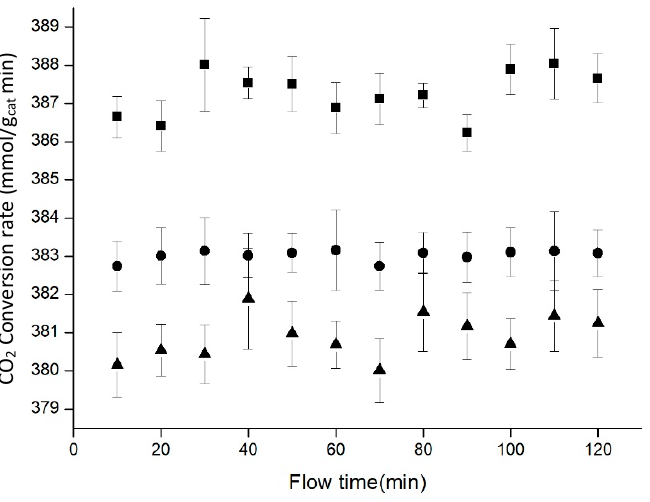
Figure 9. Influence of catalyst load on the reaction at 20 bar (7.0% ■ , 10.0% •, 13.0% ▲ ). Data points represent the average of 3 experiments, with error bars corresponding to a 95% confidence interval.